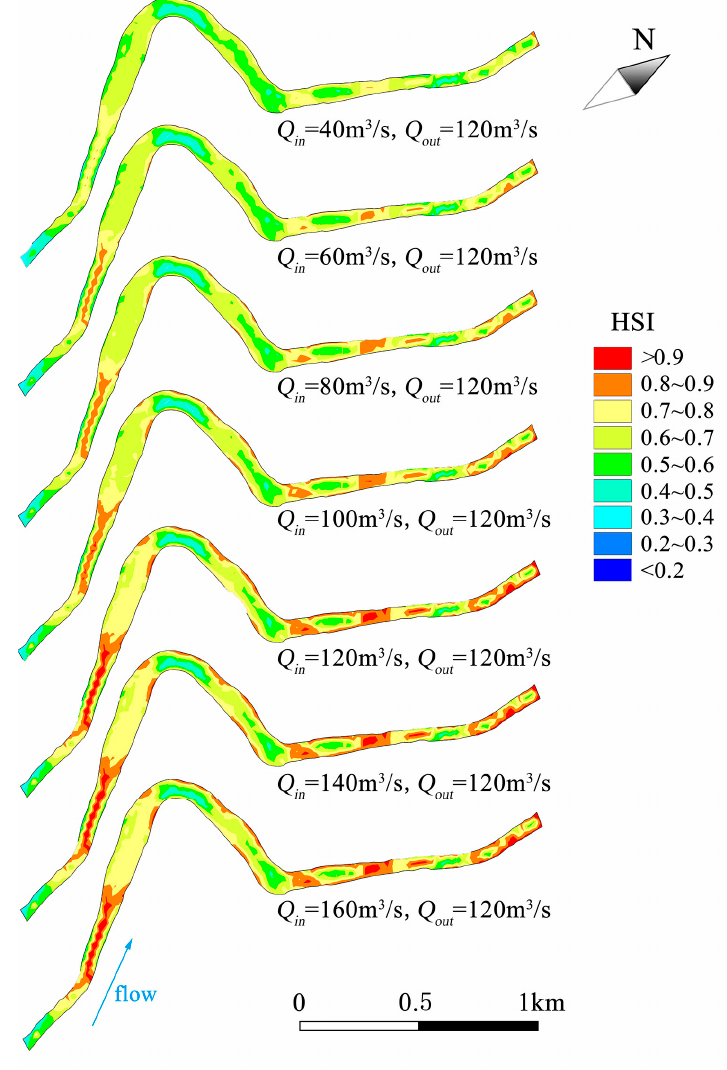
Figure 14. The spatial distribution of HSI under different inflow scenarios.